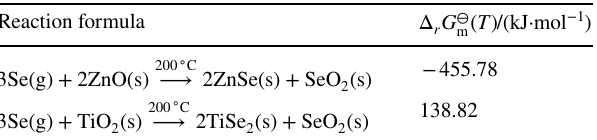
G ⊖ Δ r m of reactions between Se and ZnO (TiO 2 ) at 200 °C annealing temperature Reaction formula